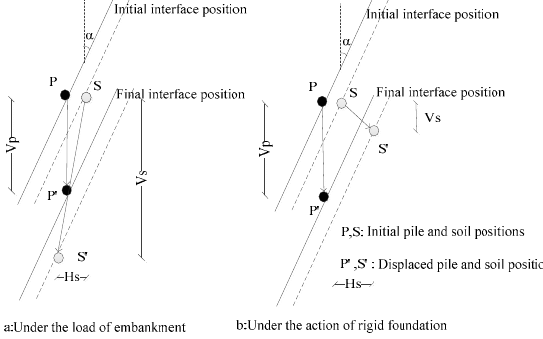
Figure 15. The relative displacement of the pile and soil.